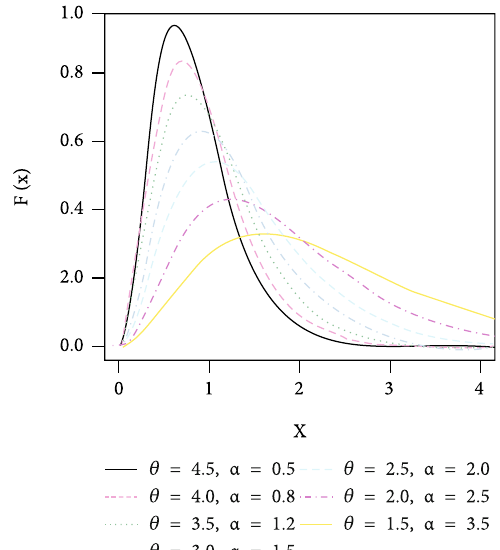
Figure 3: The pdf of DWQL